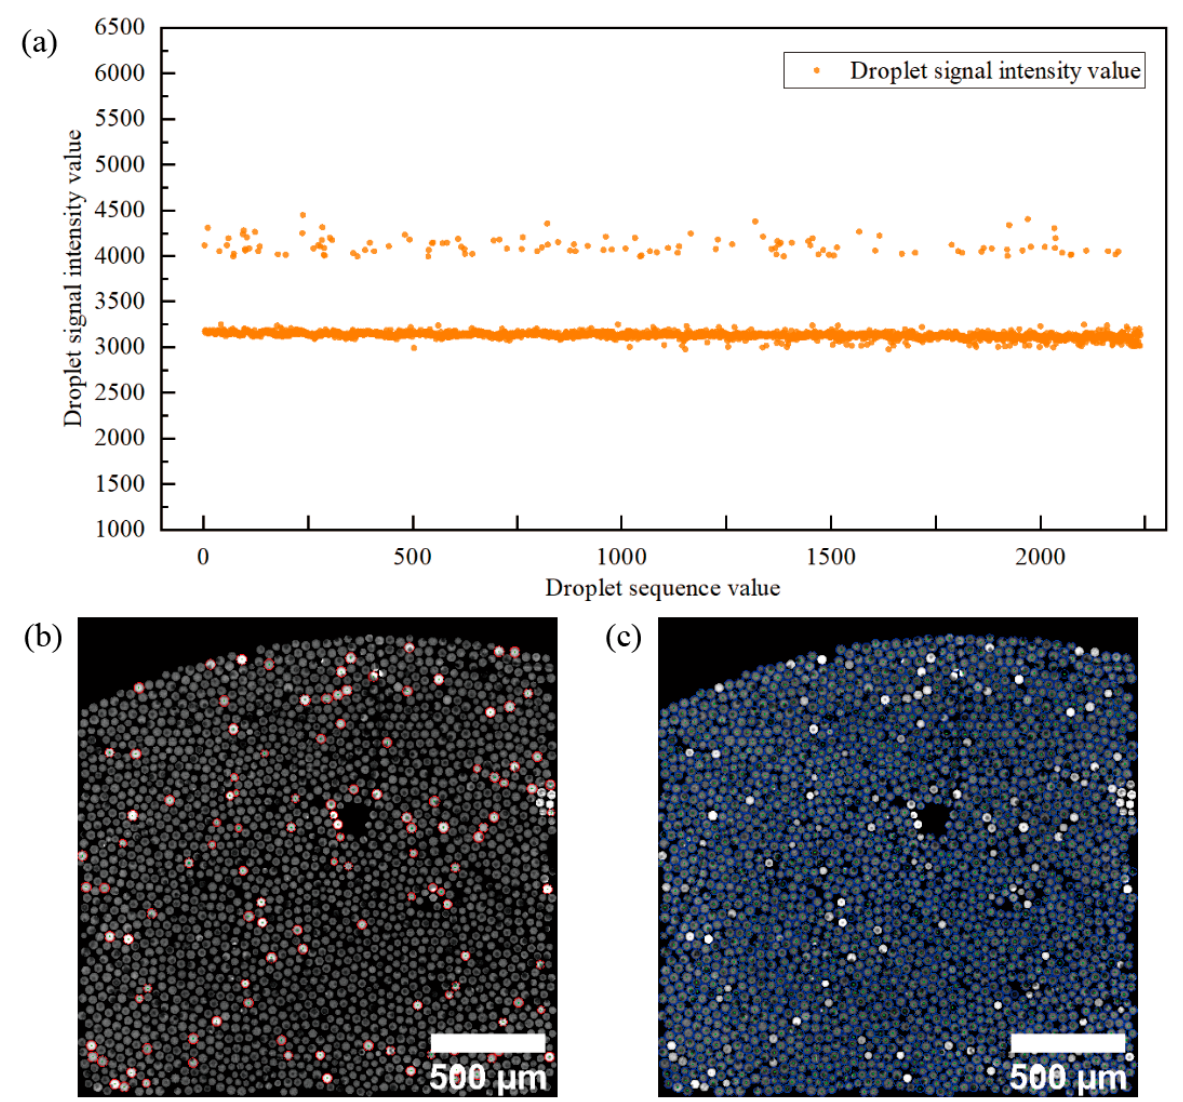
Figure 4. K-means algorithm for classification and quantification of negative and positive droplets. ( a ) the scatter plot of the positive droplet and negative droplet signals after clustering by the k-means algorithm. ( b ) The result of labeling positive droplets on the fluorescence channel image. The number of red circles indicates the number of positive droplets in the image. ( c ) The result of labeling negative droplets on the fluorescence channel image. The number of blue circles indicates the number of negative droplets in the image.